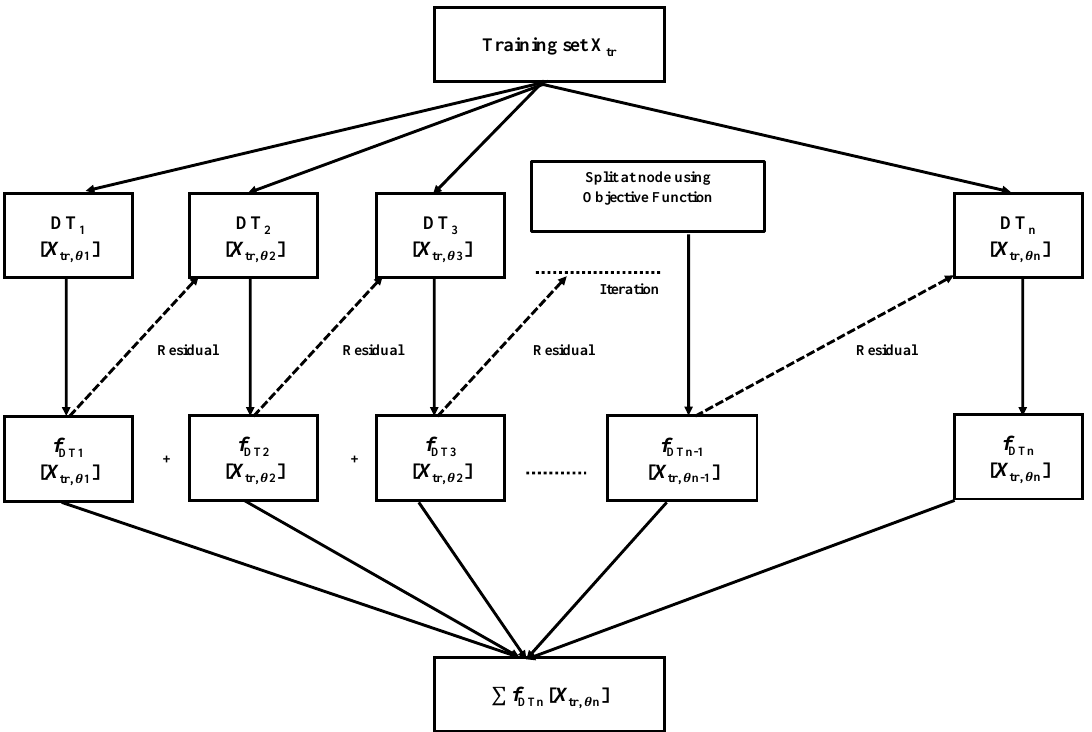
Figure 3. Flow chart of the working mechanism of the XGB algorithm in the XGB classifier. The highest accuracy was achieved by applying the XGB algorithm to the